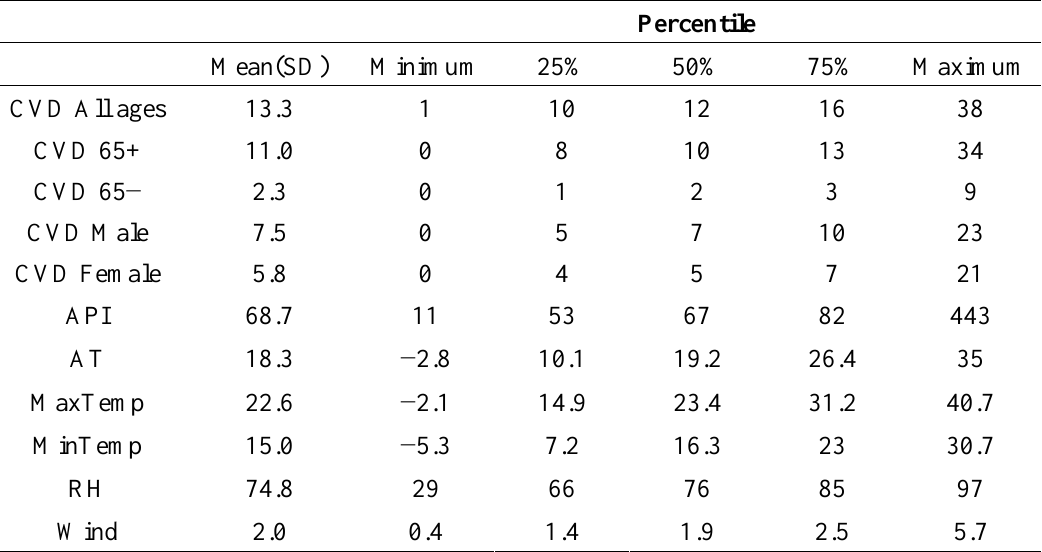
Table 1. The Distribution of CVD Mortality and Meteorological Data in Changsha.